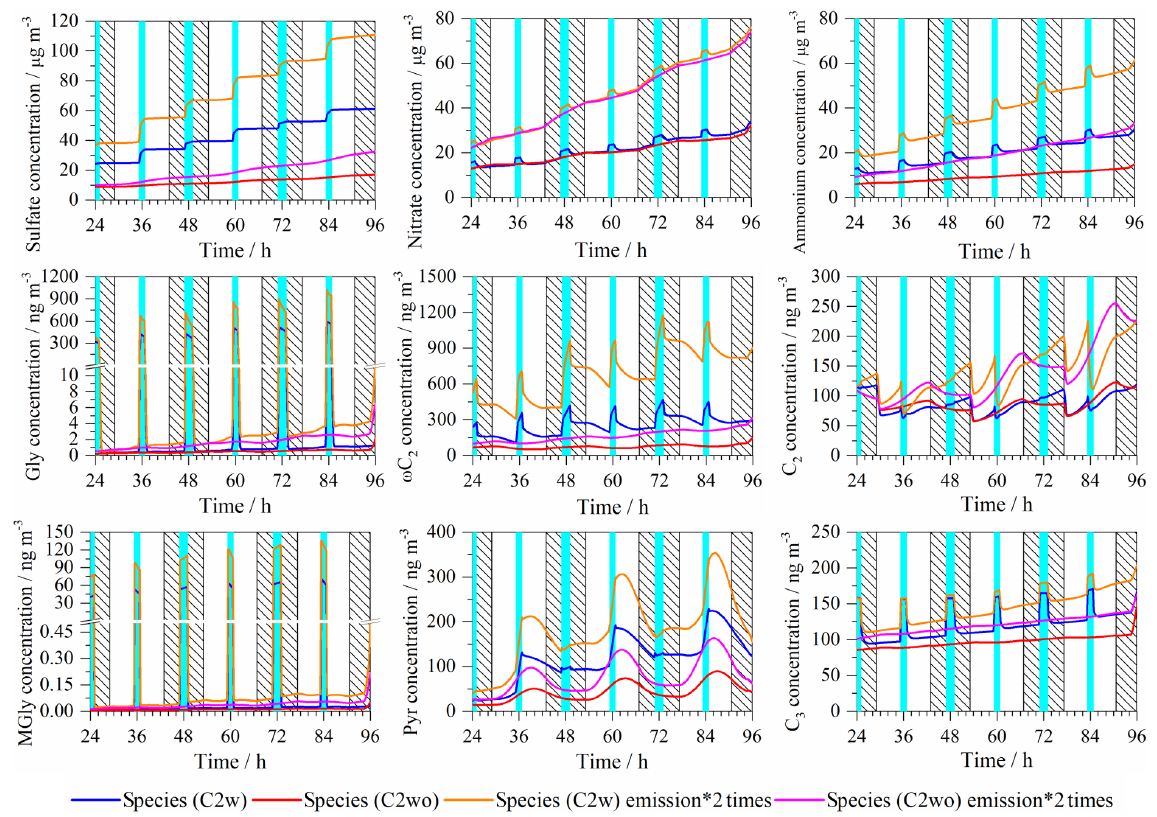
Figure 7. Concentration variations in modeled sulfate, nitrate, ammonium, Gly, ω C 2 , C 2 , MGly, Pyr and C 3 when doubling emission data (light blue column: cloud; shadow: